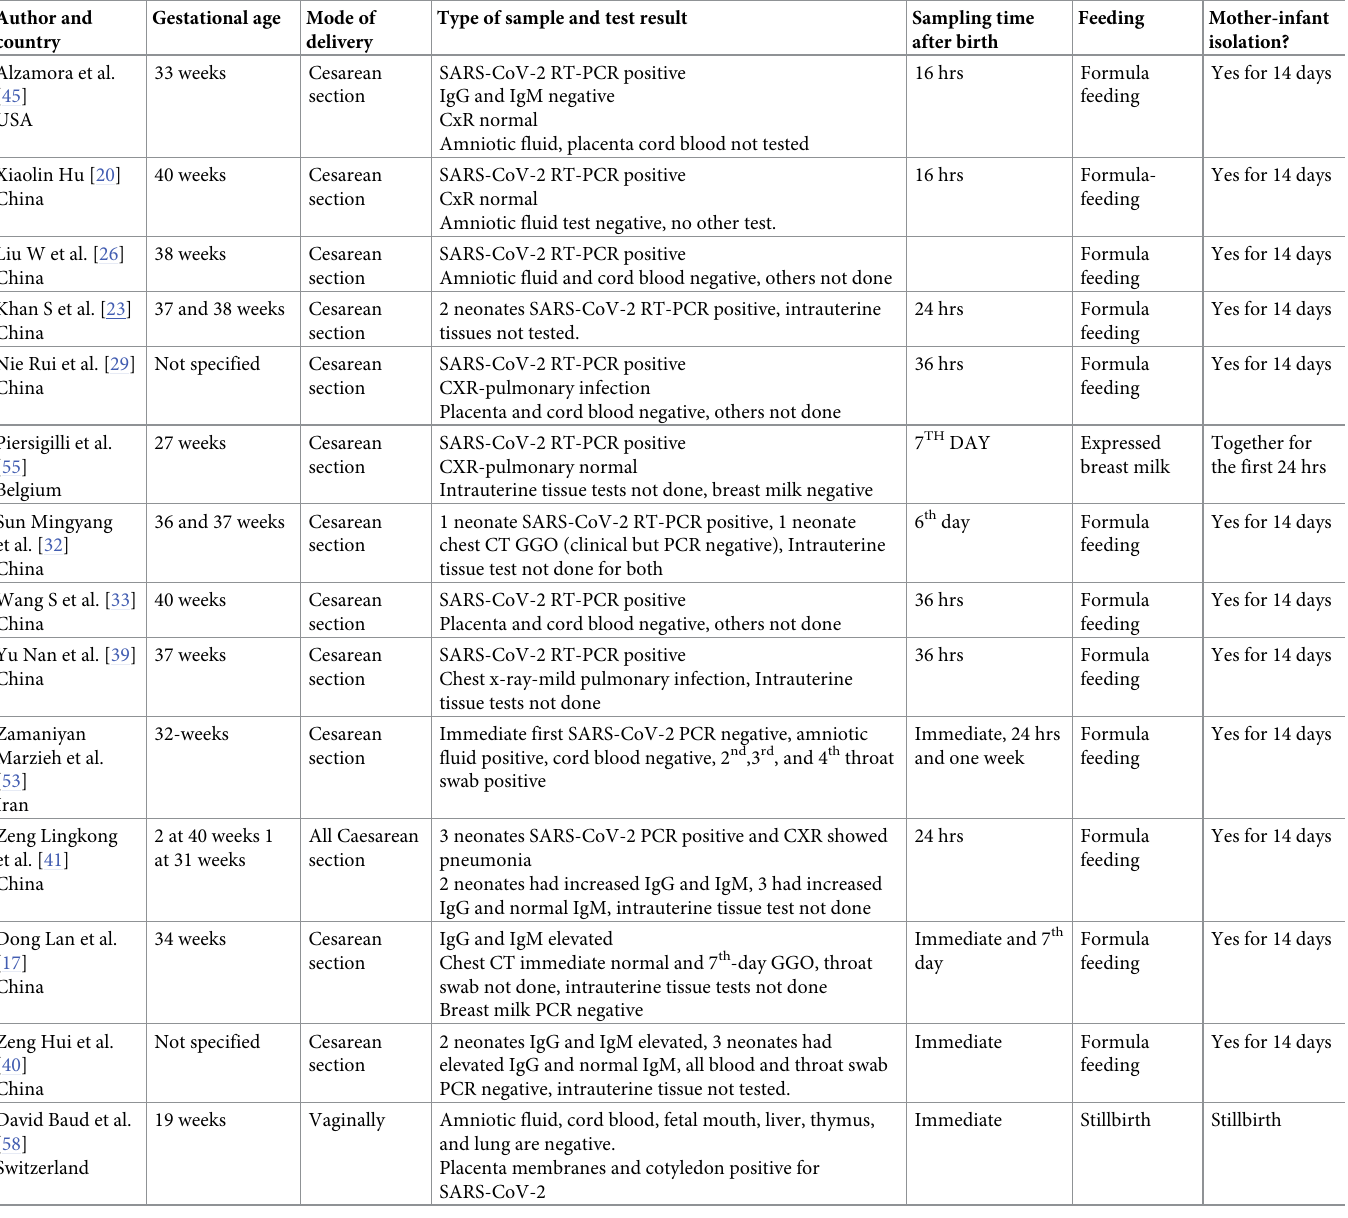
Table 2. Characteristics of studies reporting on the possibility of vertical transmission of